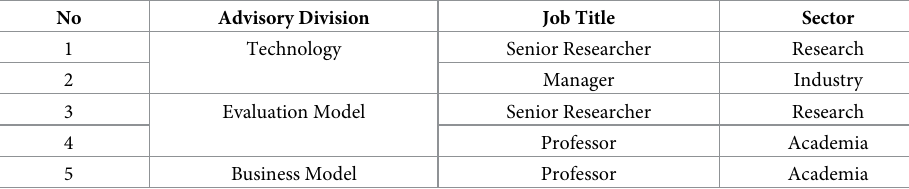
Table 2. Information about the expert advisory